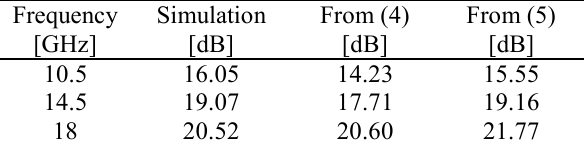
Table 2: The comparison of the directivity values obtained from simulations and measurement/equations.